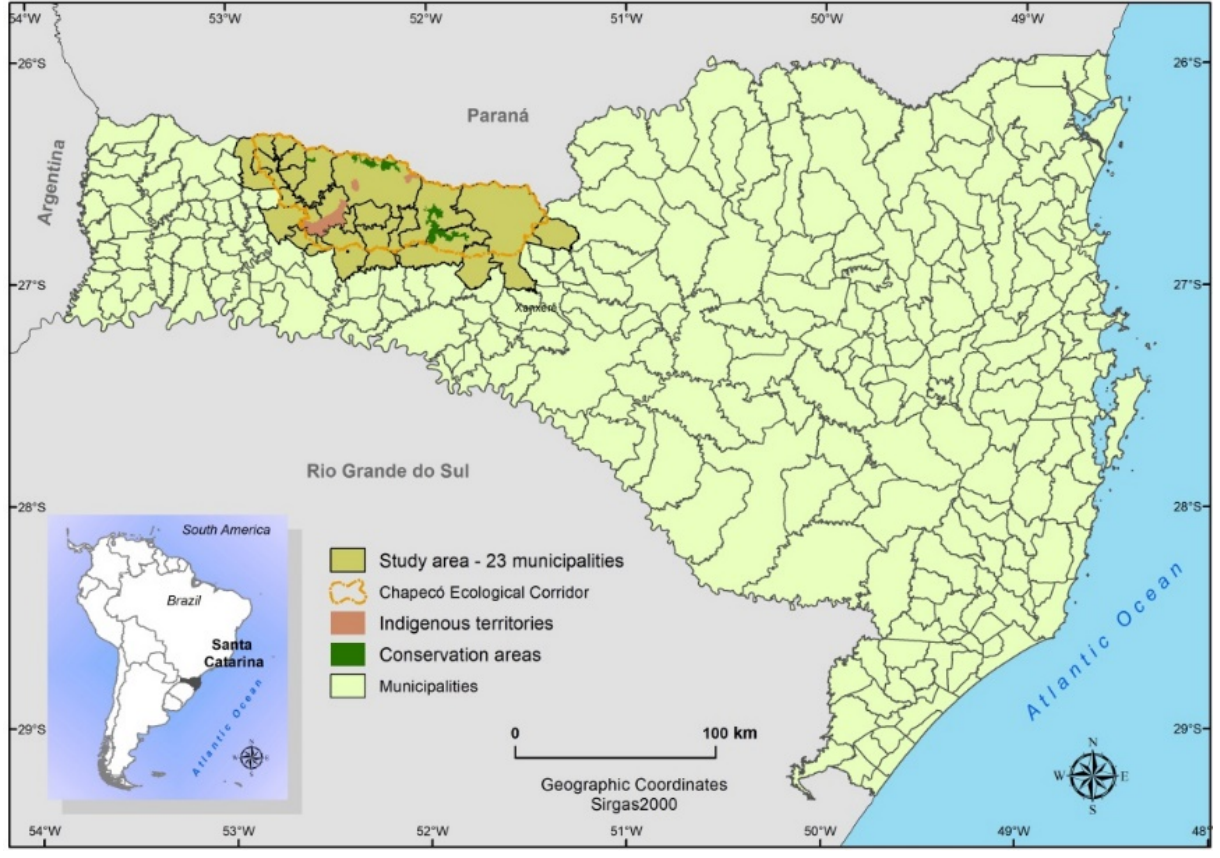
Table 1. Socioeconomic indicators. Indicators